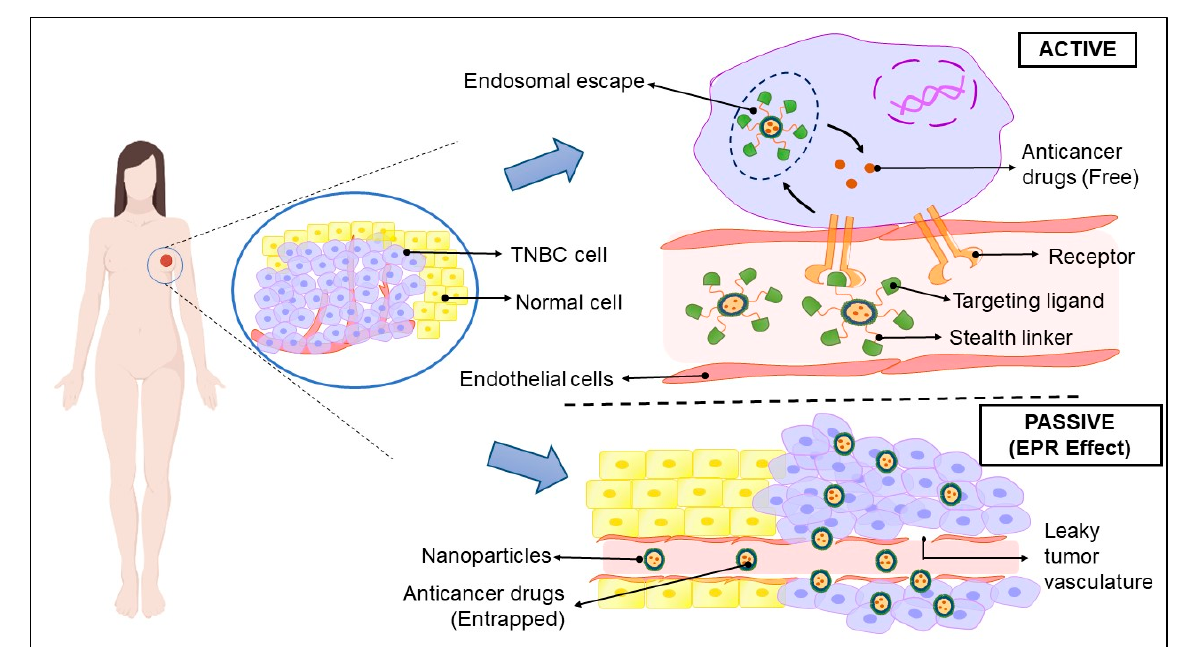
Figure 6. Schematic illustration of the passive targeting (EPR effect) and the active targeting (receptor- ligand effect) into the TNBC